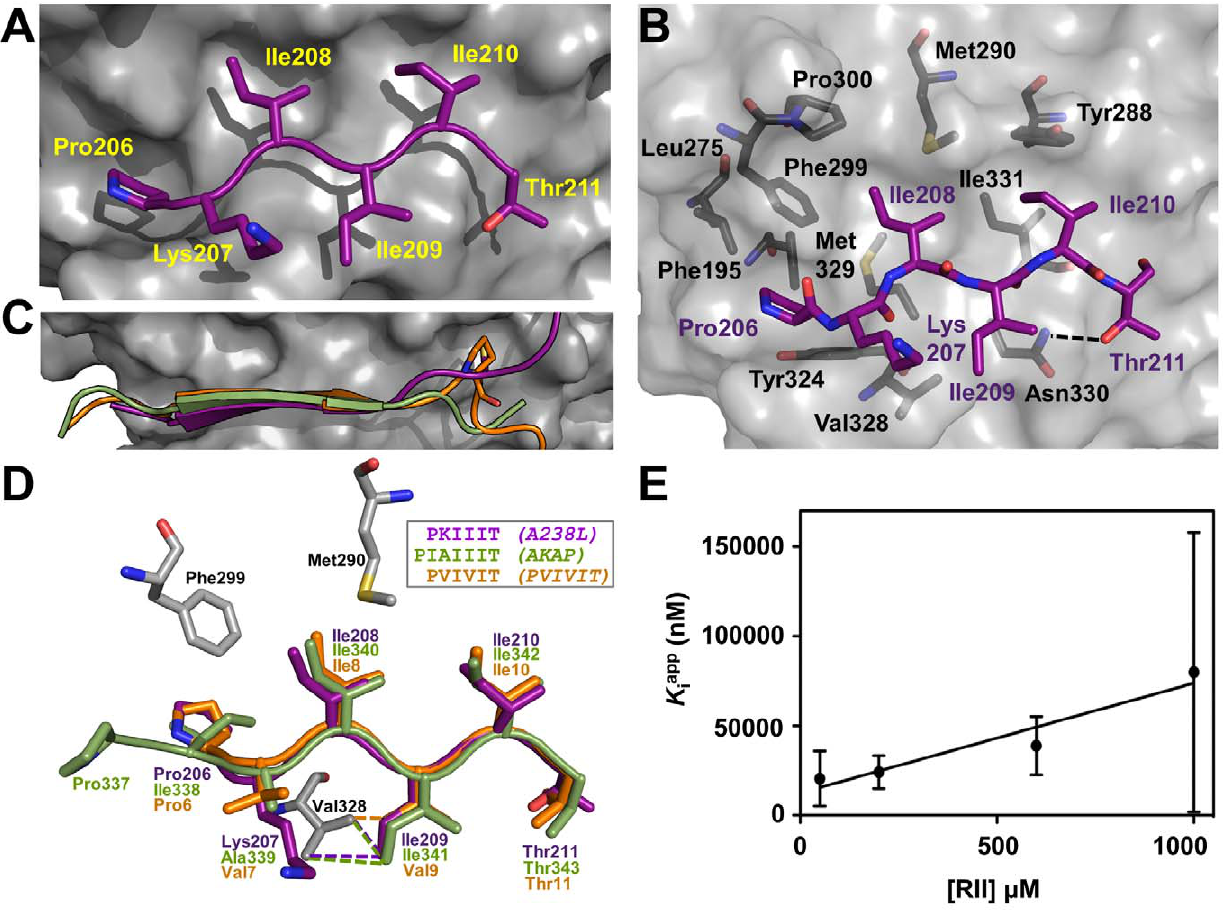
Figure 3. CN-A238L interactions: The PxIxIT substrate binding site. (A) Close-up view of the CN PxIxIT substrate binding site. A238L PKIIIT is shown as magenta sticks and labeled; CNA is shown as a grey surface. (B) Same view as (A), with a transparent CNA surface. Individual CNA residues that participate in the interaction with PKIIIT A238L are shown as grey sticks. (C) Superposition of the PKIIIT A238L motif (purple) with a synthetic PVIVIT peptide (orange) and the IAIIIT CN docking site of AKAP79 (green) bound to CN. Pro13 PVIVIT and Cys213 A238L are shown as sticks. (D) Overlay as in (C) but illustrated as sticks. Corresponding ‘‘variable’’ residues Ile209 A238L , Val9 PVIVIT , and Ile341 AKAP79 (the second ‘‘x’’ in PxIxIT) participate in the same hydrophobic interaction with Val328 CNA (dotted lines). (E) Secondary plot of K iapp as a function of [RII] for inhibition of CN by A238L FLCVKmut , which retains the PKIIIT site. Data show a linear dependence characteristic of competitive inhibition, with K i =7,700 6 3,000 nM. K iapp values were obtained from the nonlinear fit of Figure S4A. Points represent averages 6